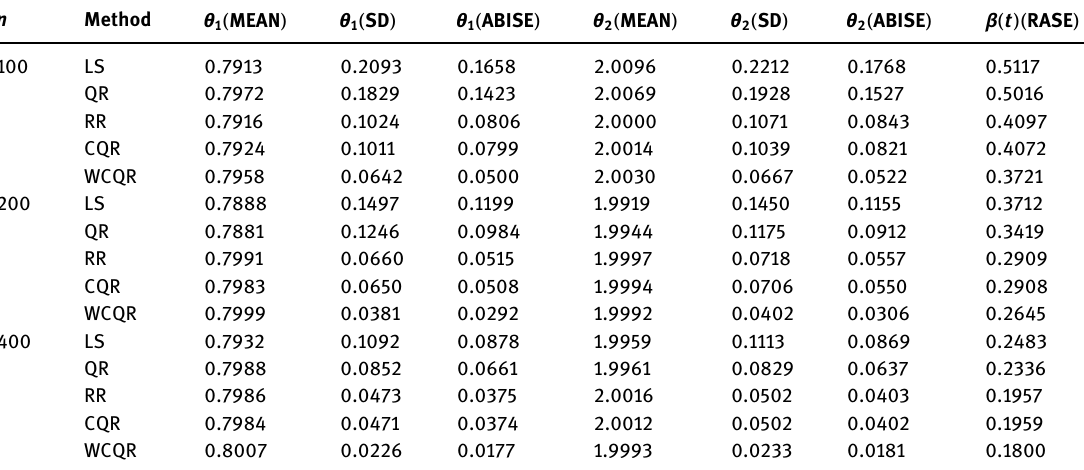
Table 6: Simulation results for θ with Wb ( 1, 1.5 ) random error n